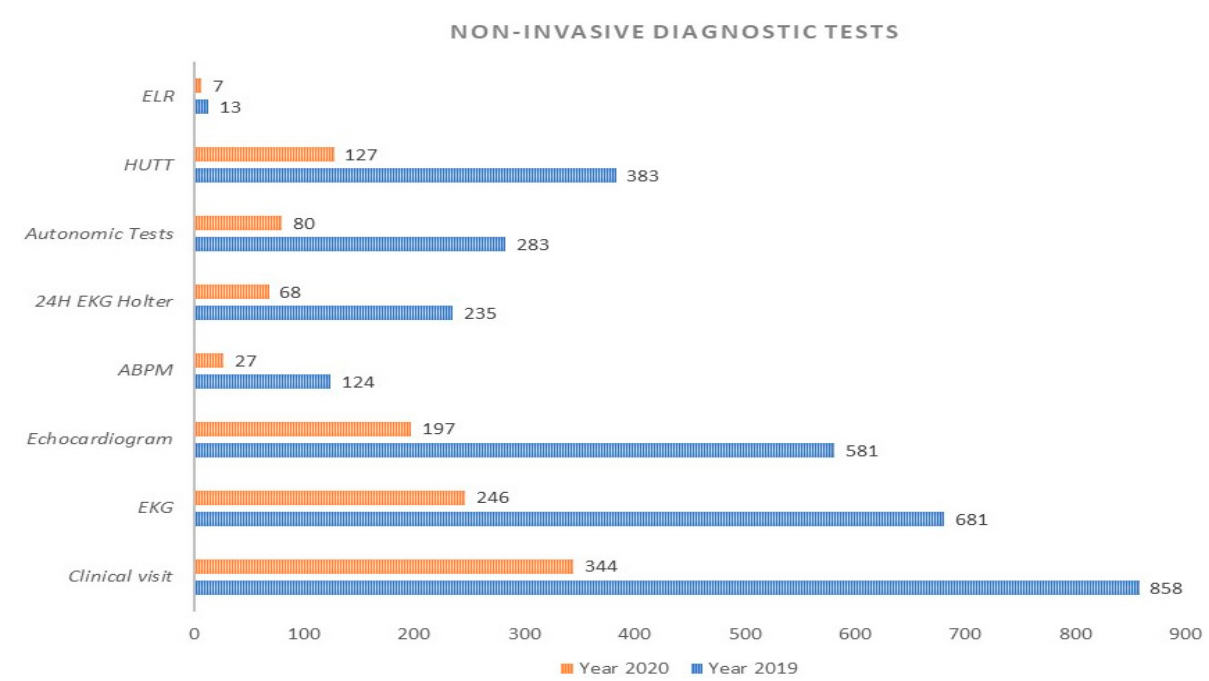
Figure 1. Number and type of non-invasive diagnostic tests performed at syncope units during 2019 and 2020 study periods. ELR: external lop recorder; HUTT: head up tilt test; EKG: electrocardiogram; ABPM: ambulatory blood pressure monitoring.